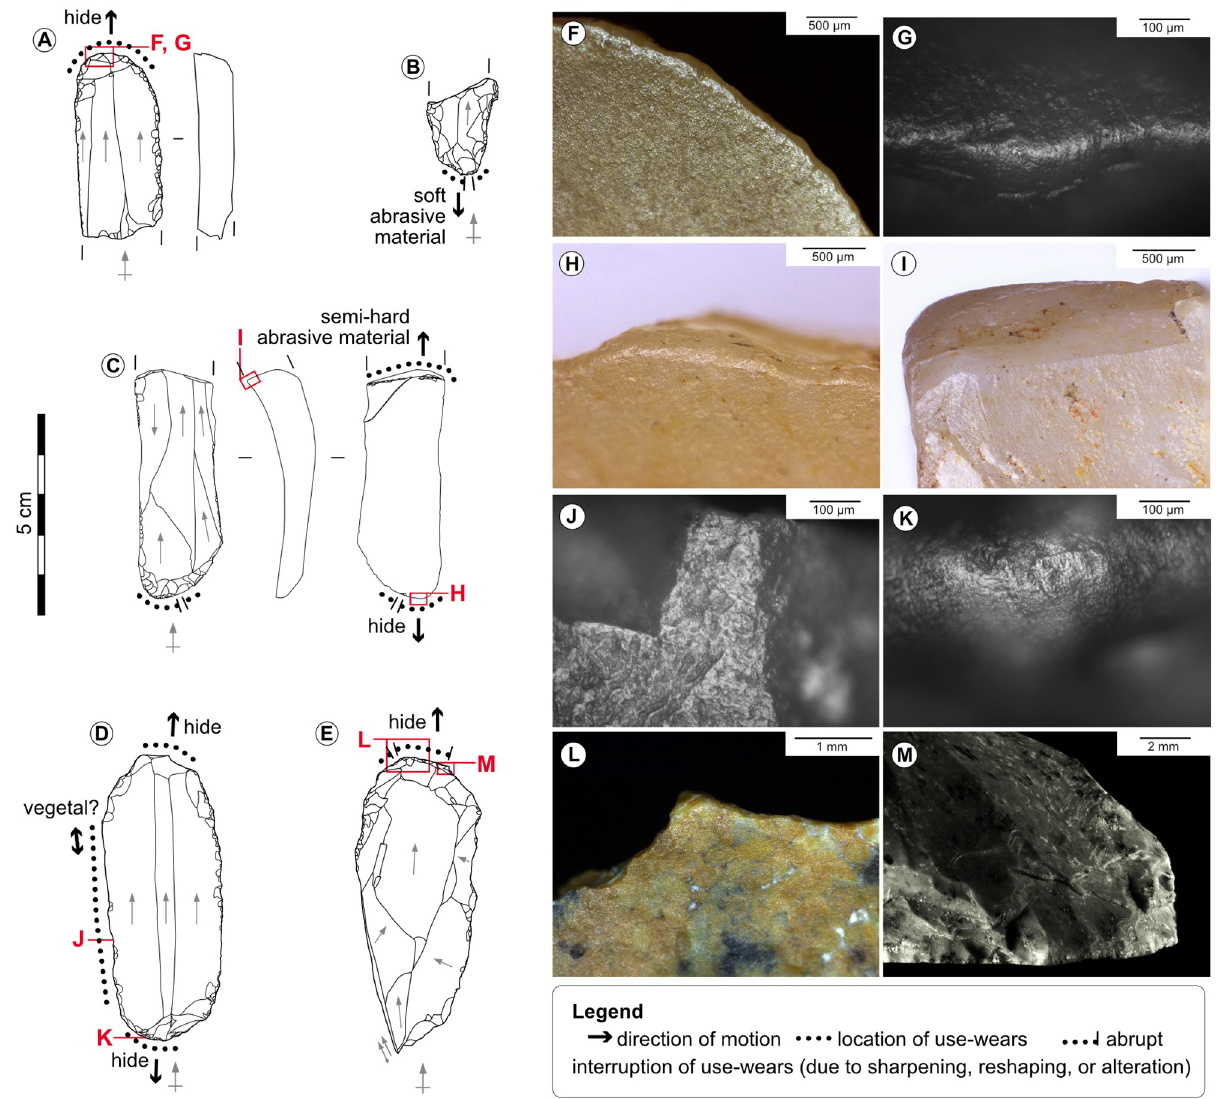
Fig 11. Used endscrapers. A-Endscraper on retouched blade from the Blanchard cave, layer B4. B-Endscraper on retouched blade from the Blanchard cave, layer B4/B5. C-Endscraper on blade from the Blanchard cave, layer B4/B5. D-Double endscraper on blade from La Marche. E-Endscraper-burin from La Marche. F, G-Rounding, shine, striations and polish of dry hide scraping on the distal end of tool n˚A, credits: Gauvrit Roux, 2019. H-Rounding and striations due to dry hide scraping on the proximal end of tool n˚C. I-Profile view of the fracture edge of tool n˚C showing rounding due to scraping of a semi-hard abrasive material. J-Probable wood sawing micro-wears on the lateral edge of tool n˚D. K-Dry hide scraping micro- wears on the proximal end of tool n˚D. L-Hide rounding interrupted by direct sharpening retouch on the distal end of tool n˚E. M-Abrupt edge caused by successive sharpenings of the distal end of tool